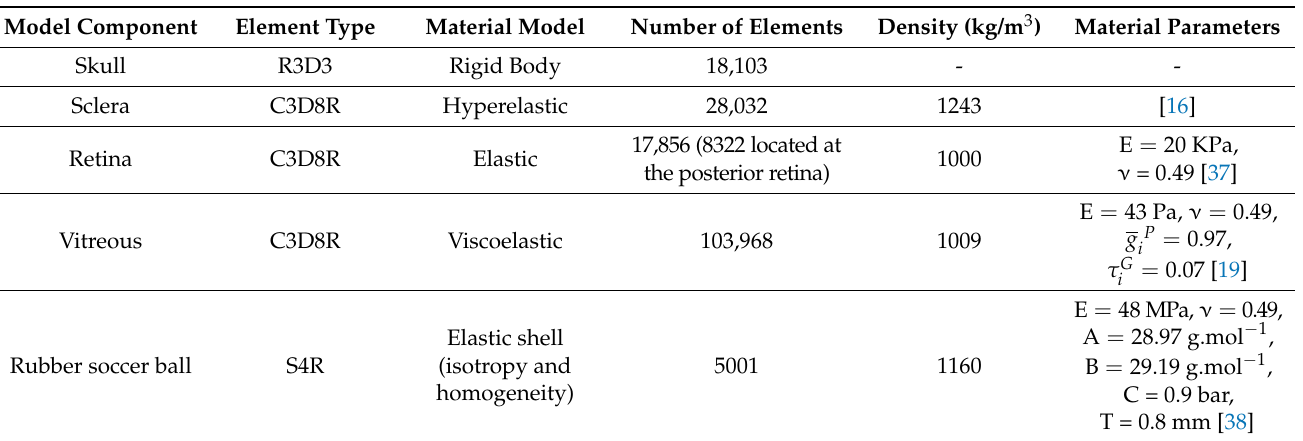
Table 1. Material parameters of the FE model and the number of